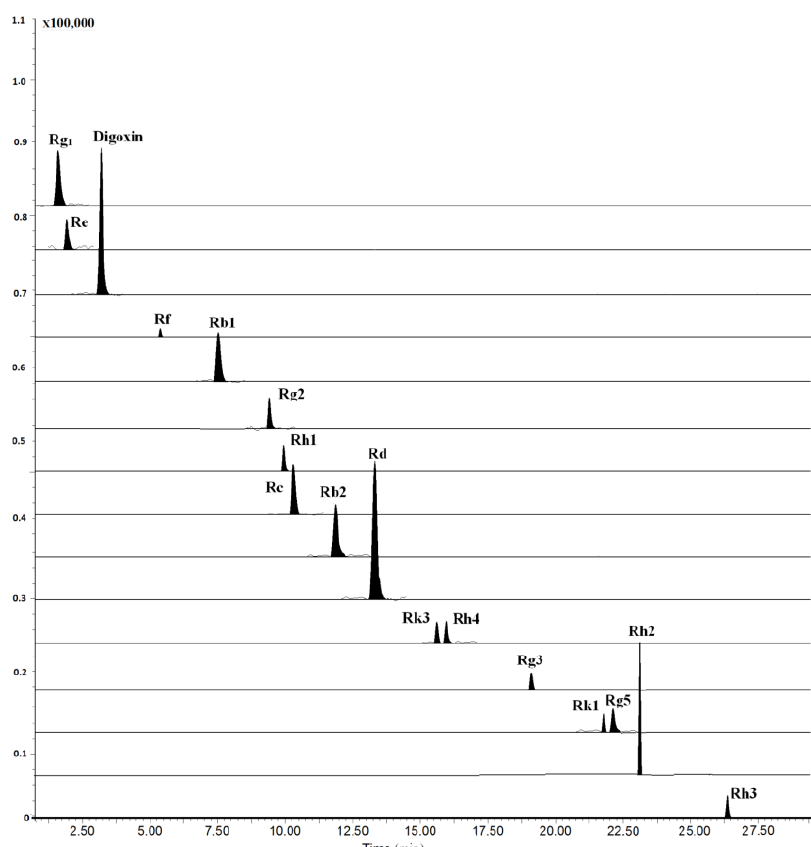
Figure 2. Typical multiple reactions monitoring (MRM) chromatograms of rat plasma collected at 4 h after oral administration of 100 mg/kg RGS.